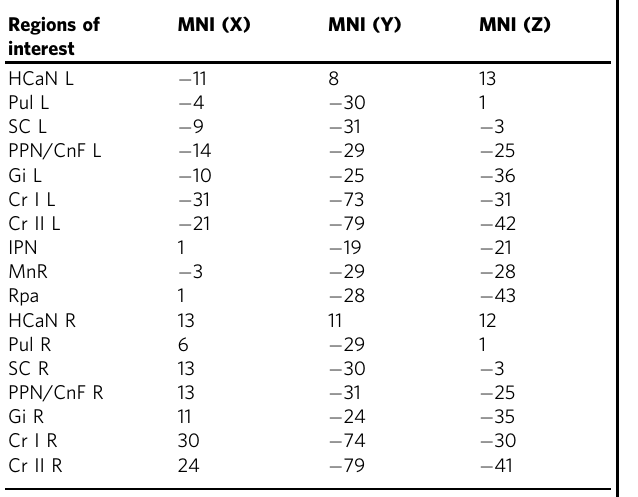
Table 1 MNI coordinates of the VAN subcortical regions ’ centers of gravity.